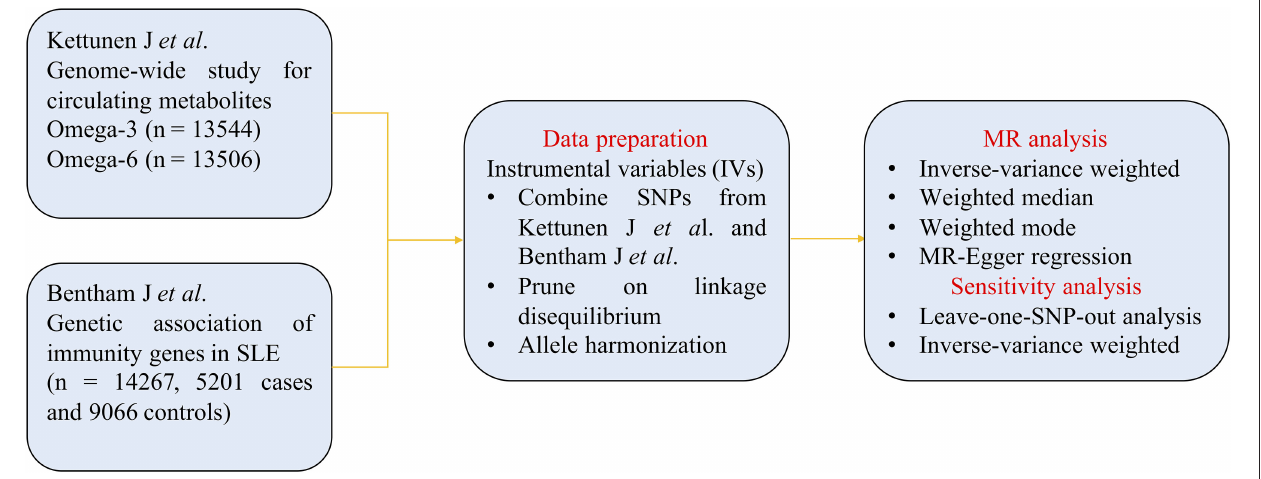
FIGURE 1 | The flowchart of Mendelian randomization